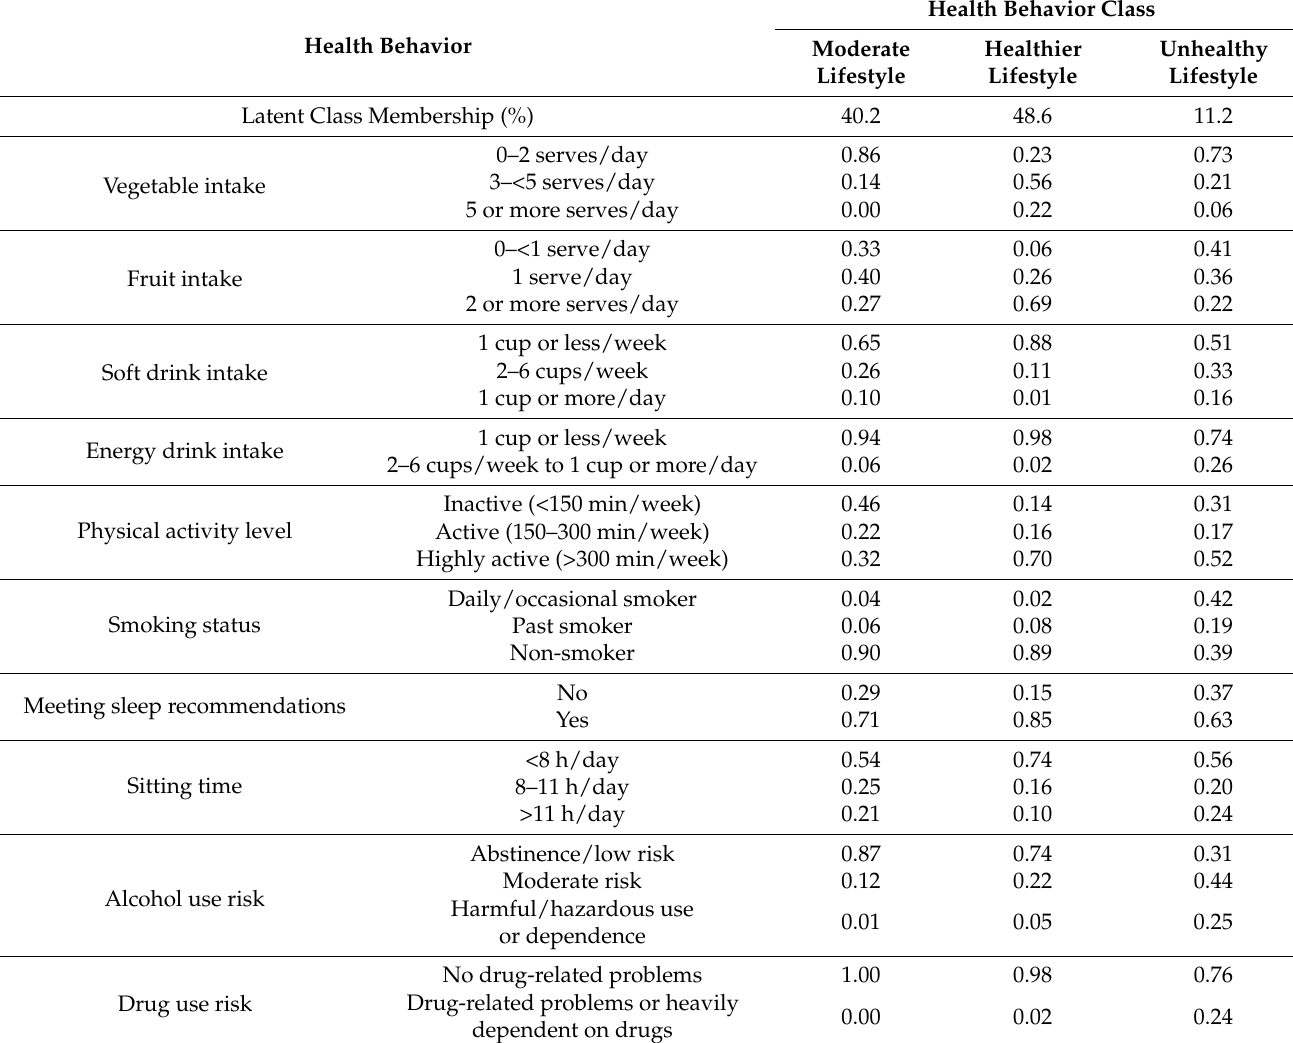
Table 2. Latent class analysis item response probabilities for health behaviors among a sample of Australian university students ( n =